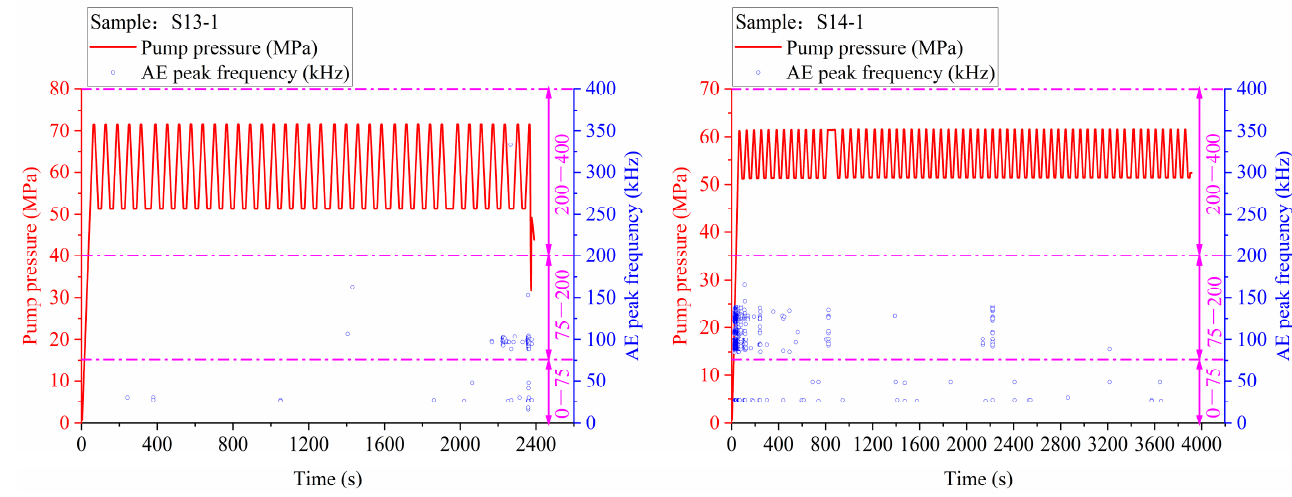
Figure 15. The relationship between the AE peak frequency and injection time of the samples.